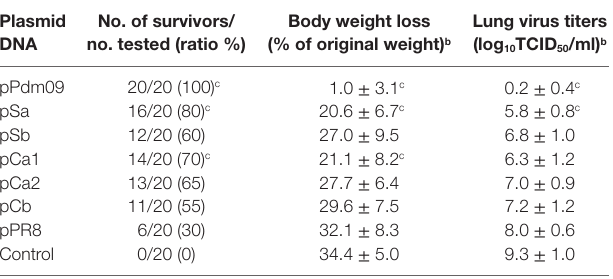
TaBle 2 | Protection against lethal virus challenge of mice immunized with plasmid DNAs substituted with one epitope of the Pdm09 HA. a Plasmid no. of survivors/ Dna no. tested (ratio %)